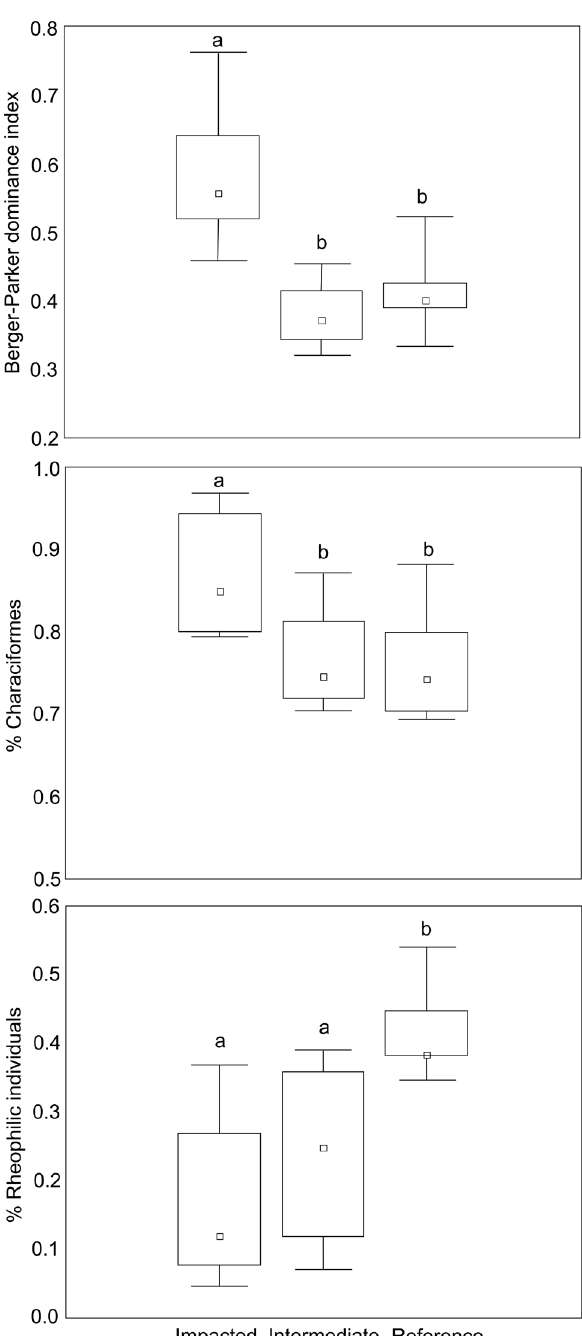
Figure 3. Box-and-Whisker plots of the three sensitive metrics. Rect- angles represent the 1 st and 3 rd quartiles, small squares are medians, bars are maximum and minimum values. Different letters indicate statistically significant differences. ZOOLOGIA 35: e12895 | DOI: 10.3897/zoologia.35.e12895 | March 22,